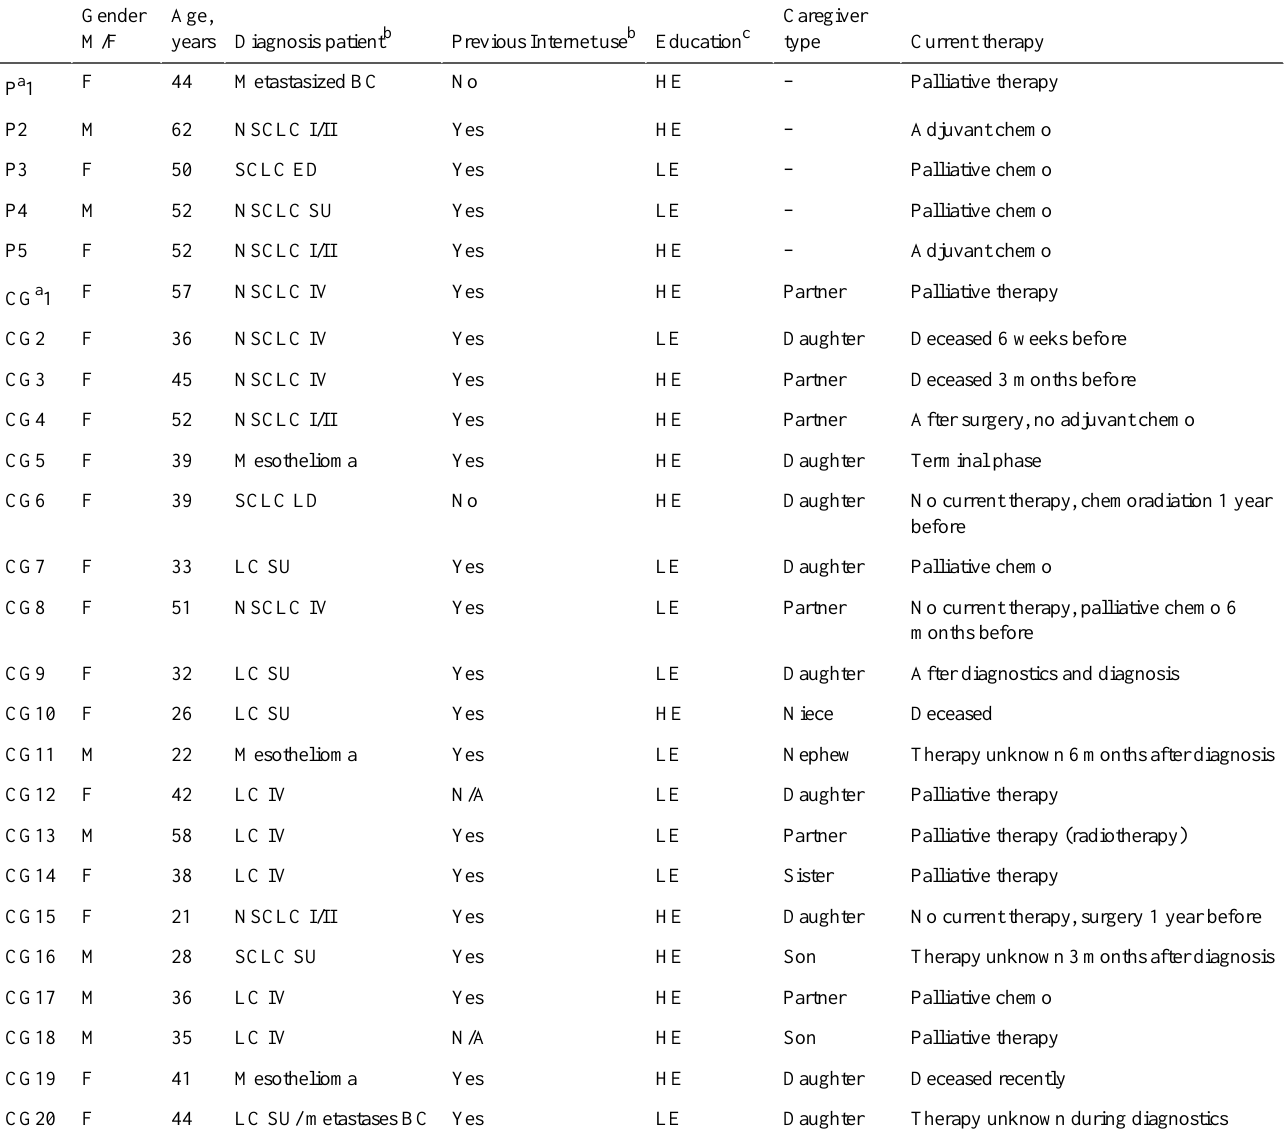
Table 1. Study population characteristics and Internet use